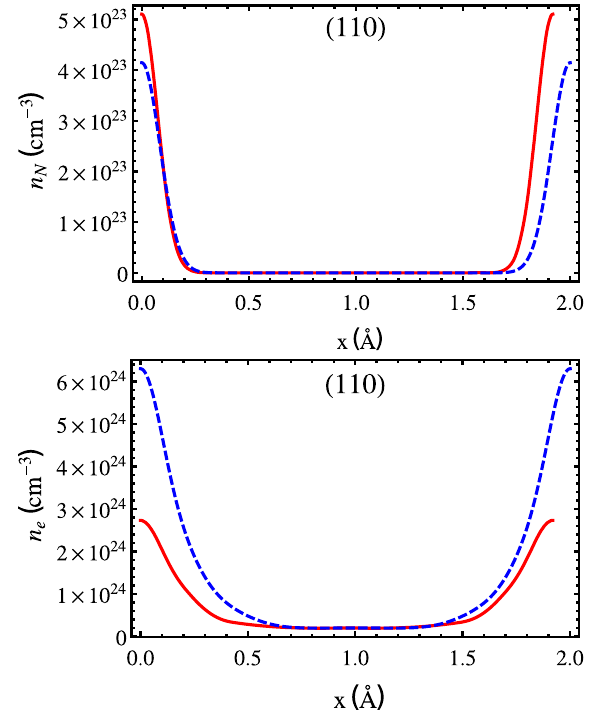
FIG. 2. Interplanar nuclear (top) and electron (bottom) densities in a silicon (solid) and germanium (dashed) crystals between (110) crystal